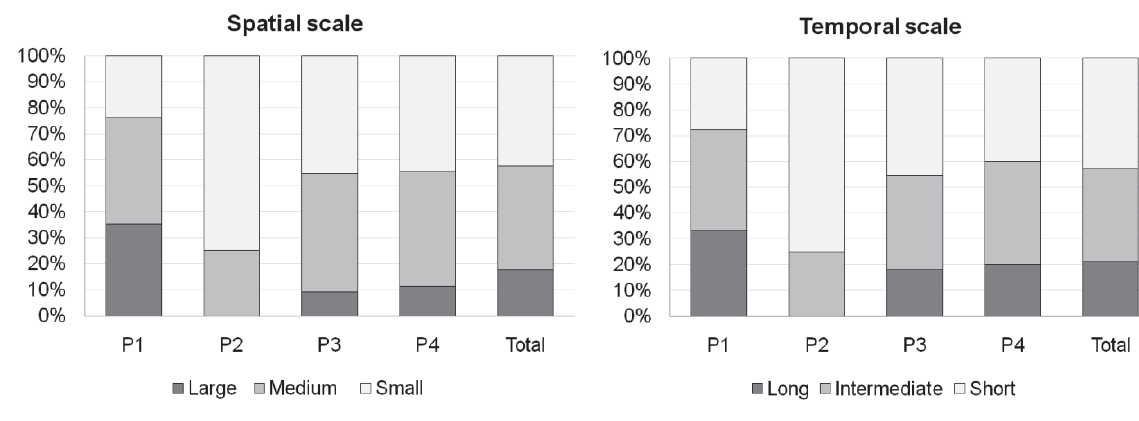
Figure 1. The scales of investigation used in the forest related research undertaken by academics within the centre ( n = 27). For scale levels, see